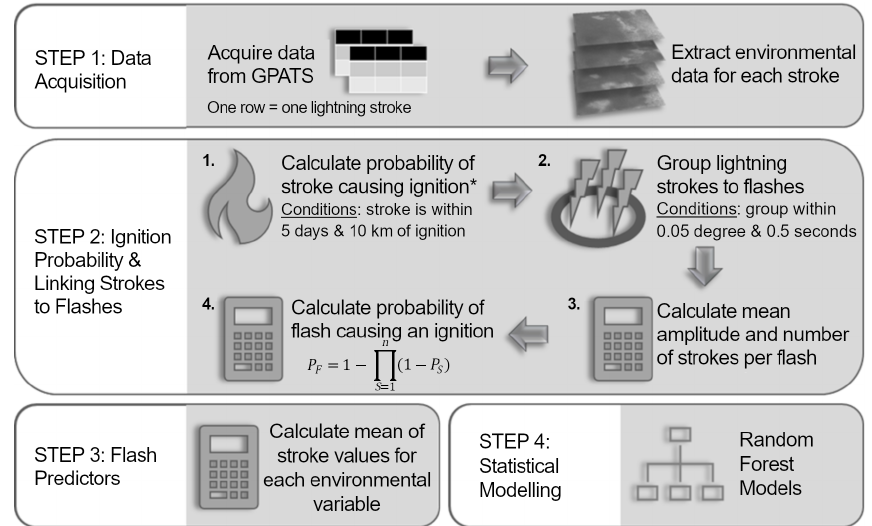
Figure 2. Lightning data manipulation process. Here, a lightning flash is composed of several strokes that can differ in their duration, strength (amplitude) and polarity. Strokes can follow the same channel to the ground or can branch and have several terminals near the ground. ∗ Equations for the calculation of stroke ignition probability are described in text following the method outlines in Larjavaara et al.